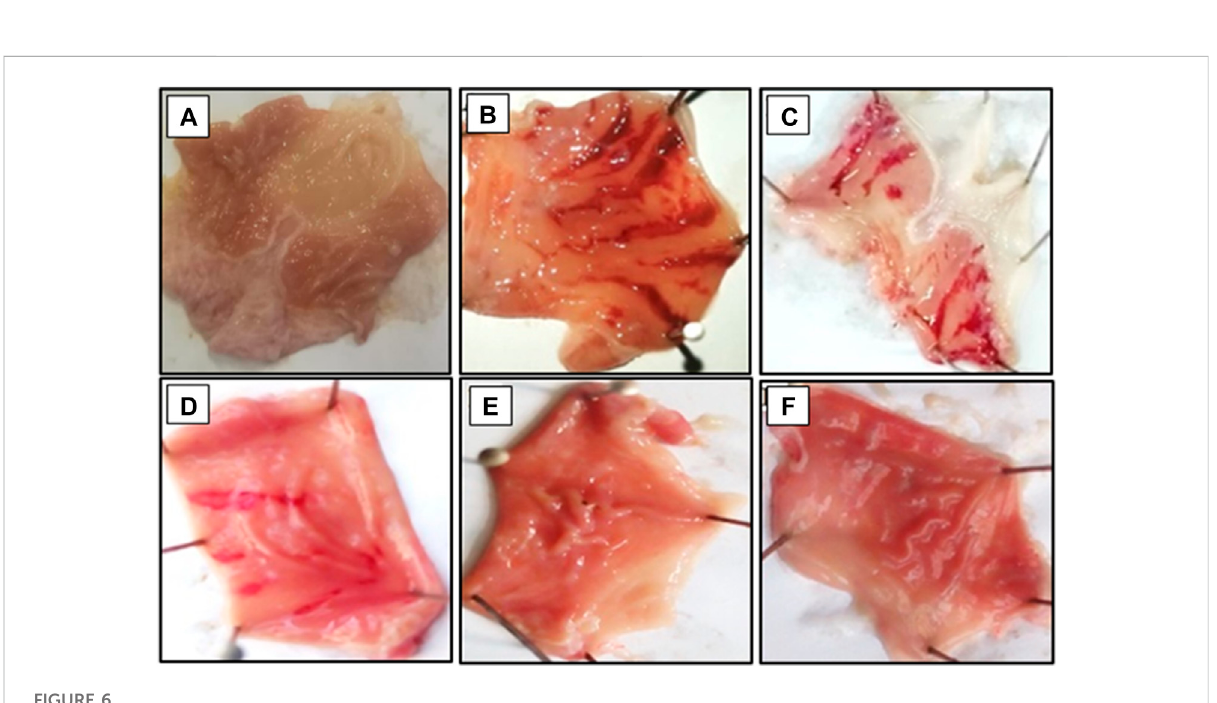
the atomic positions for bergapten on 4UX2 is shown in Supplementary Figures S15A and bergapten on IT3S is shown in Supplementary Figure S15B. Root mean square deviation (RMSD) of interaction between 4UX2 and IT3S with bergapten is shown in Figures 1A,B, respectively. Small deviation in RMSD shows stable binding. Interactionsofbergaptenwithdifferentaminoacid residues on 4UX2 and 1T3S are displayed in Figures 2A1,A2, respectively. Some residues form more than one speci fi c contact with the ligand, which is depicted as darker shade of orange. Other interactions including H-bonds, hydrophobic, ionic, and water bridges between bergapten vs. 4UX2 and 1T3S are represented in Figures 2B1,B2, respectively.